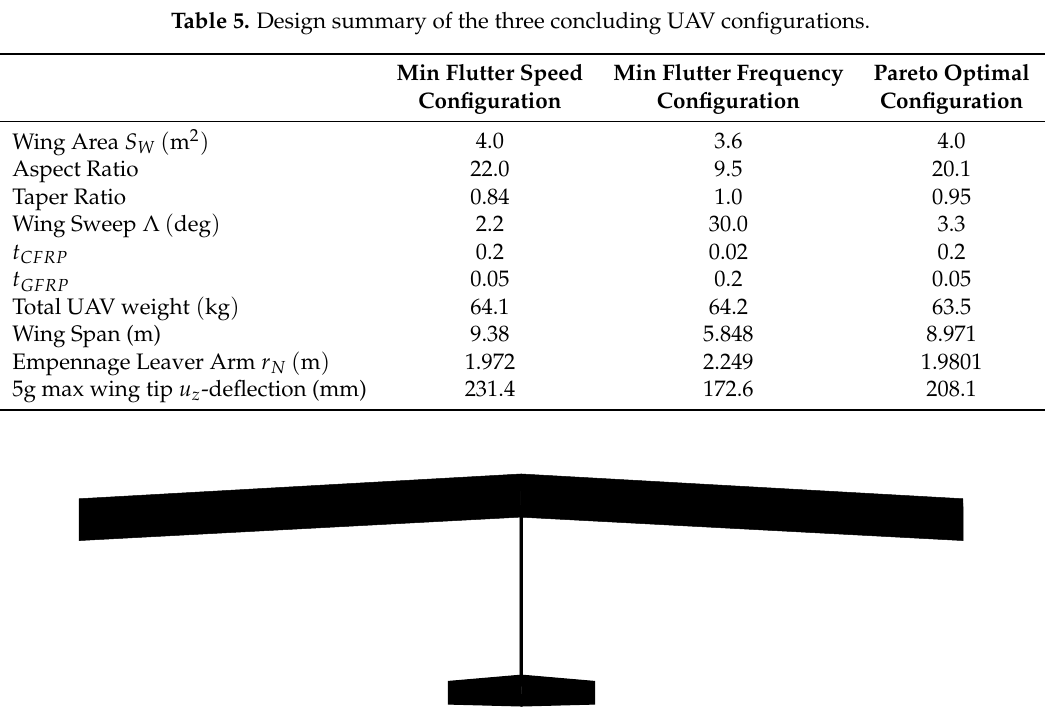
Figure 10. Wing plane form of Pareto optimal UAV configuration, S = 4.0m 2 , AR = 20.1, TR = 0.95, Λ = 3.3deg.